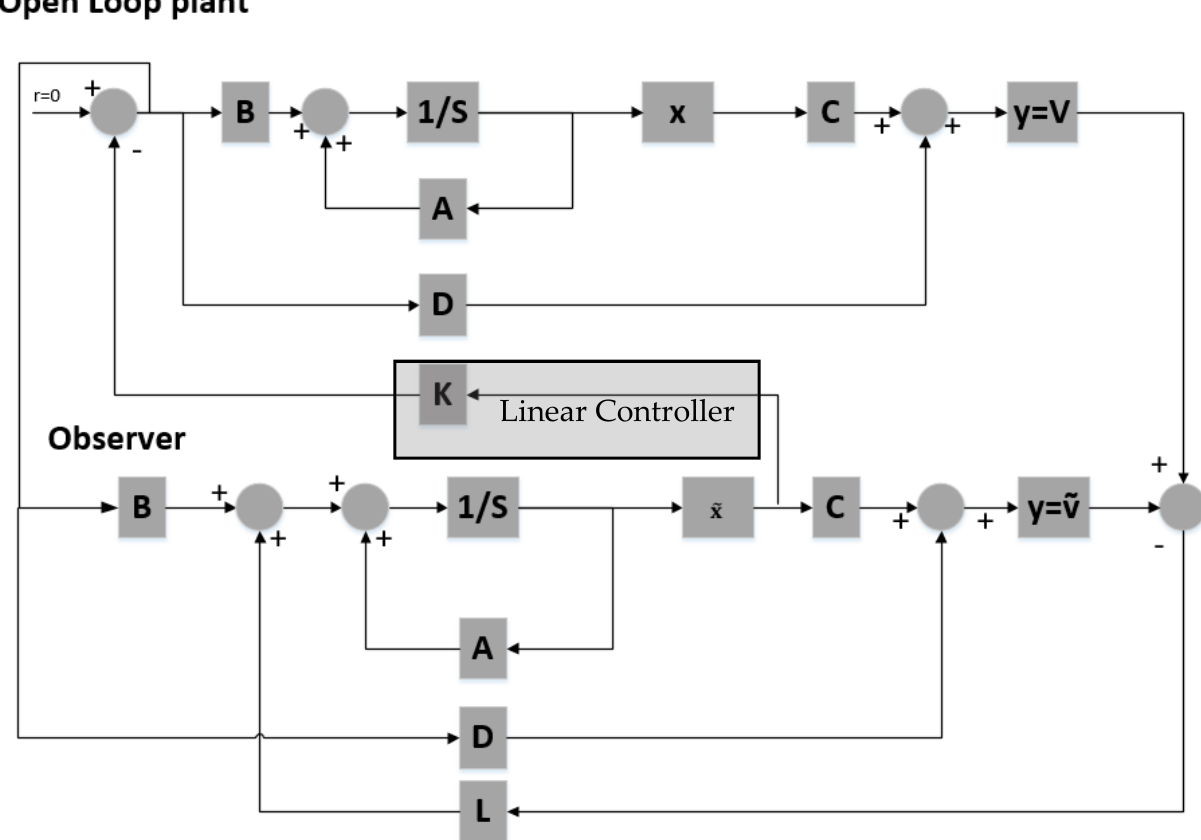
Figure 12. Closed loop block diagram.